Question: Write a caption explaining this figure to a reader.
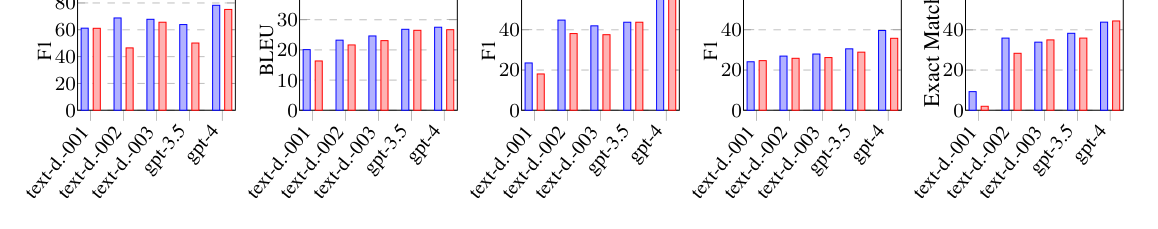
Answer: Performance of BASE (in purple) and AMRCOT (in red) on 5 datasets across 5 model versions: text-davinci-001|-002|- 003, GPT-3.5 and GPT-4.